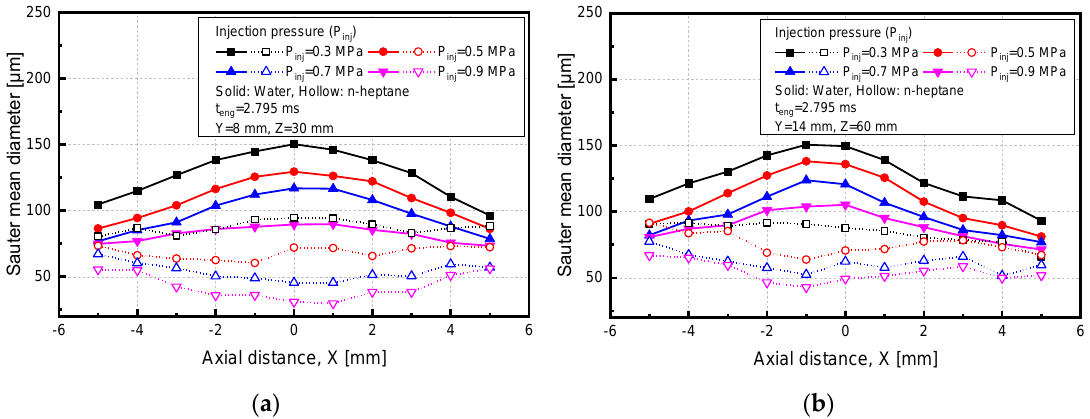
Figure 9. Average size characteristics of water and n-heptane under different injection pressure at ( a ) D tip = 30 mm, ( b ) D tip = 60 mm.